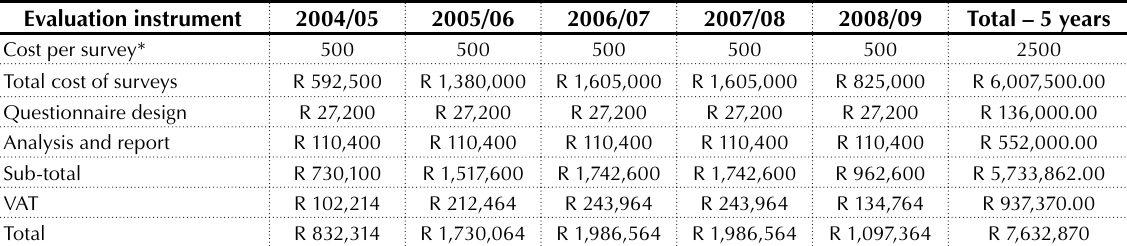
Table 1. The cost of evaluating the Expanded Public Works Programme Source: Employment and Economic Policy Research Unit, HSRC